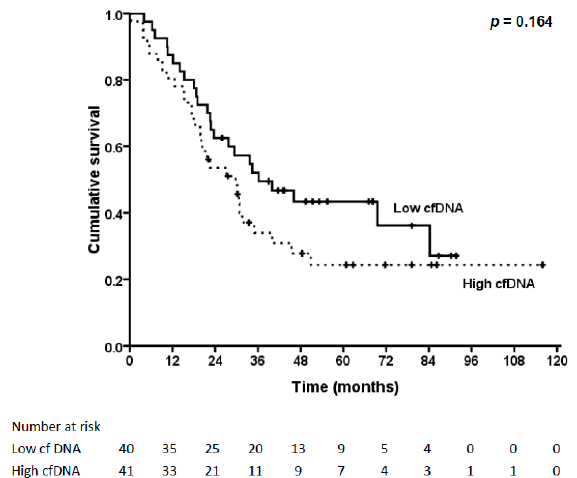
Figure 3. Kaplan–Meier survival curve and log-rank test of different cfDNA levels in overall survival (OS) of ESCC patients. Patients with lower cfDNA levels had better OS, but not significantly ( p = 0.164).